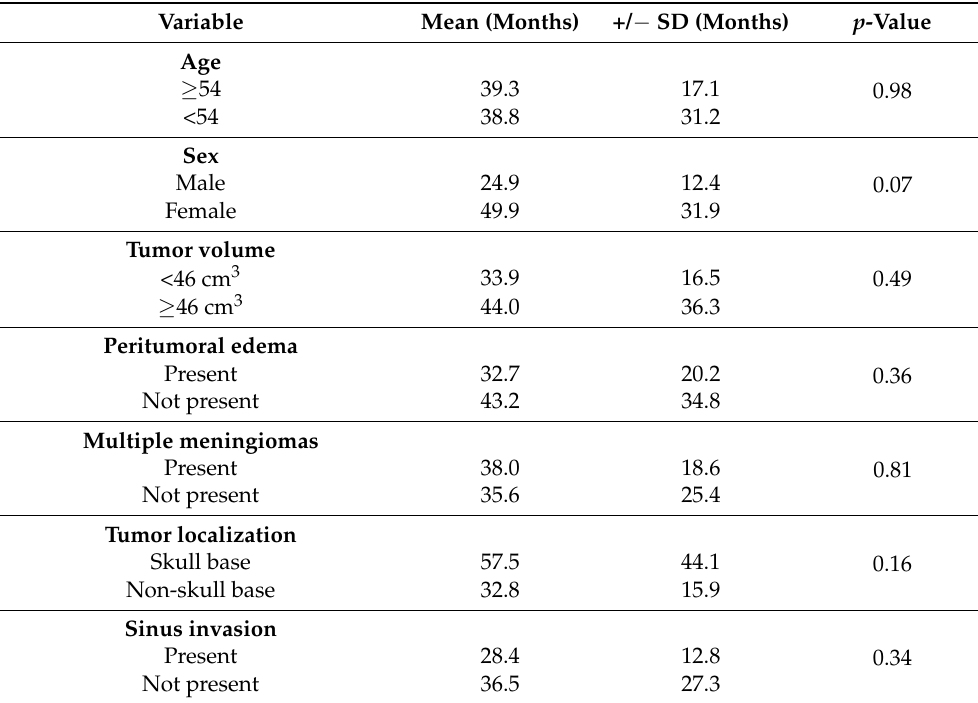
Table 3. Association between clinical, imaging, histopathological features, and the time to recurrence. Significant results ( p < 0.05) are shown in bold